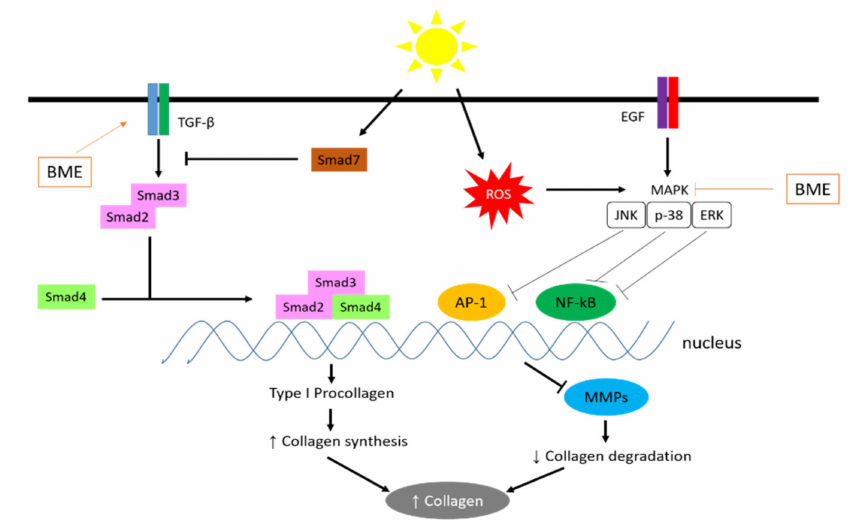
Figure 6. Mechanisms of action of B. macrophylla Griffith as an